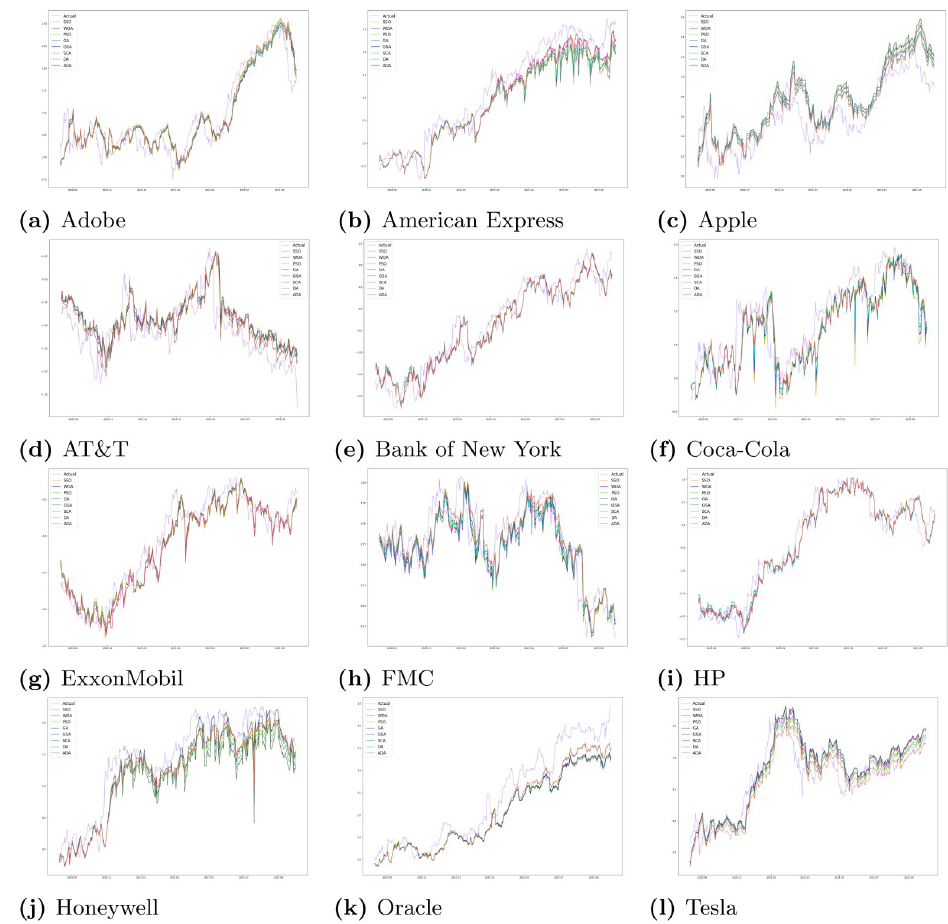
Fig 3. Predicted stock prices of 12 companies using 8 different algorithms. (a) Adobe, (b) American Express, (c) Apple, (d) AT&T, (e) Bank of New York, (f) Coca-Cola, (g) ExxonMobil, (h) FMC, (i) HP, (j) Honeywell, (k) Oracle, (l) Tesla.